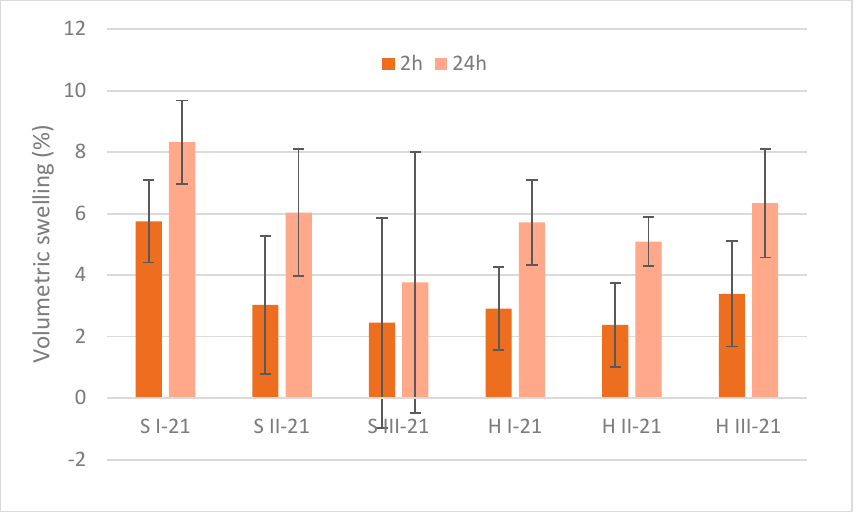
Figure 4. Volumetric swelling of final mycelium biocomposites after 21 day development. S = sawdust; H = hemp; I, II, III = variants.